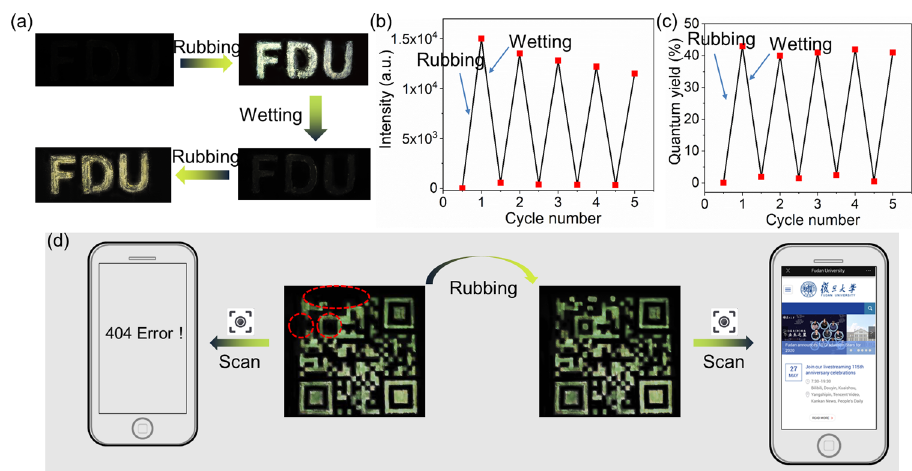
Fig. 5 Material application. a Photographs under a UV light showing the “ FDU ” character printed using 3 upon the reversible operation of the rubbing luminescence in the solid state; b emission intensity; and c luminescent quantum yield of 3 in the solid state with repeated rubbing and wetting for several cycles; d photographs of a QR code printed using 3 (for the areas with red circles) and a persulfurated arene as the other routine luminescent material to showcase an application of information